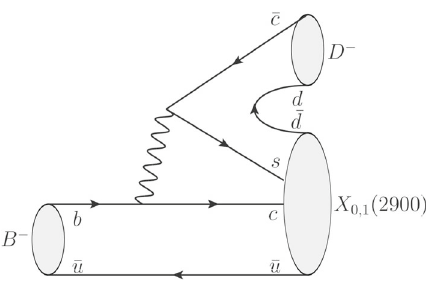
Fig. 1 The topological diagram of the B − → D − X 0 , 1 ( 2900 ) decays